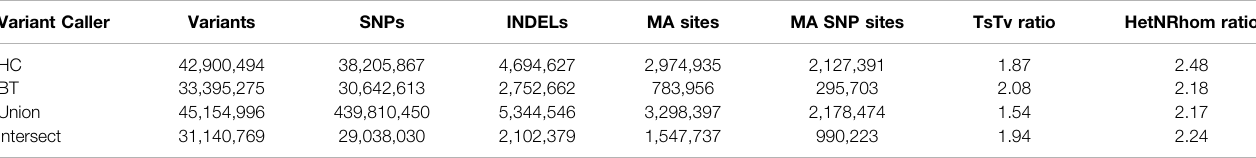
TABLE2| Numberofvariants,TsTv,andHetNRhomratiofrom534WGSidenti fi edbyeachvariantcaller[GATKHaplotypeCaller(HC)andBCFtools(BT),andtheunionand intersection of the variant callers]. Variant